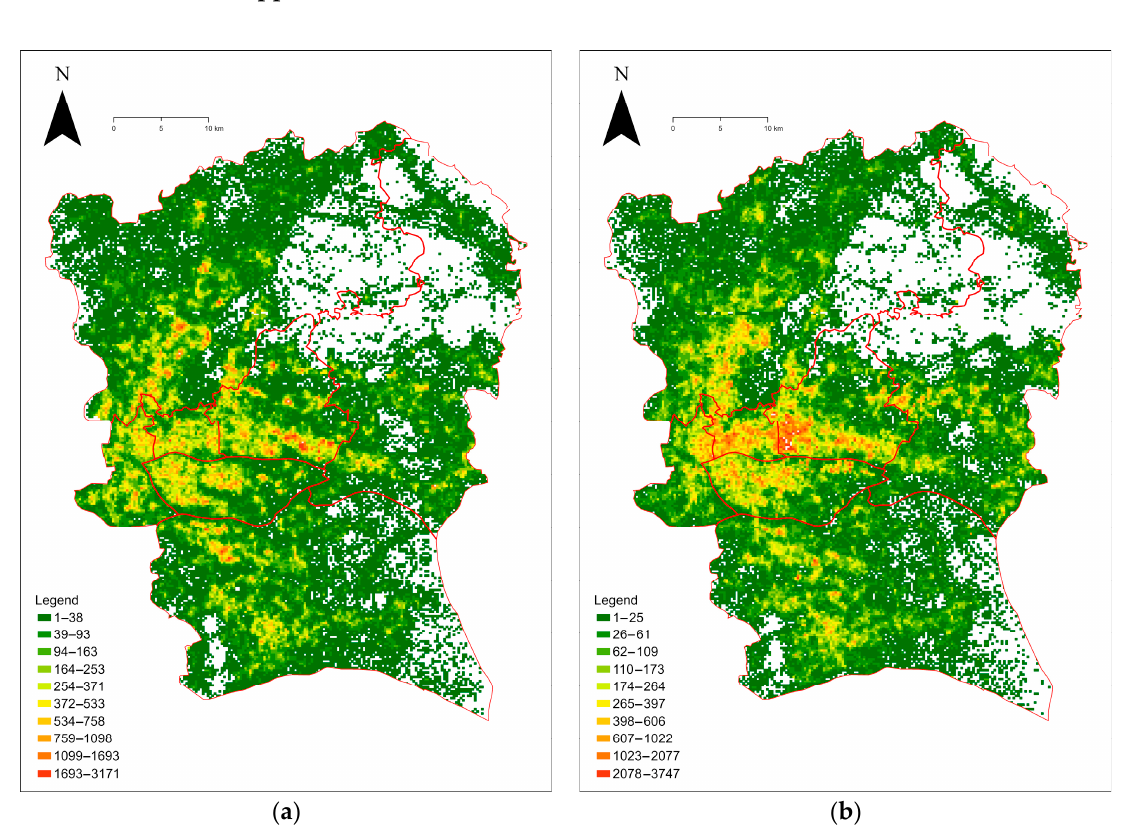
Figure A1. Results of the grid aggregated mobile phone data: ( a ) summary of the number of women living in the grid; ( b ) summary of the number of women working in the grid.